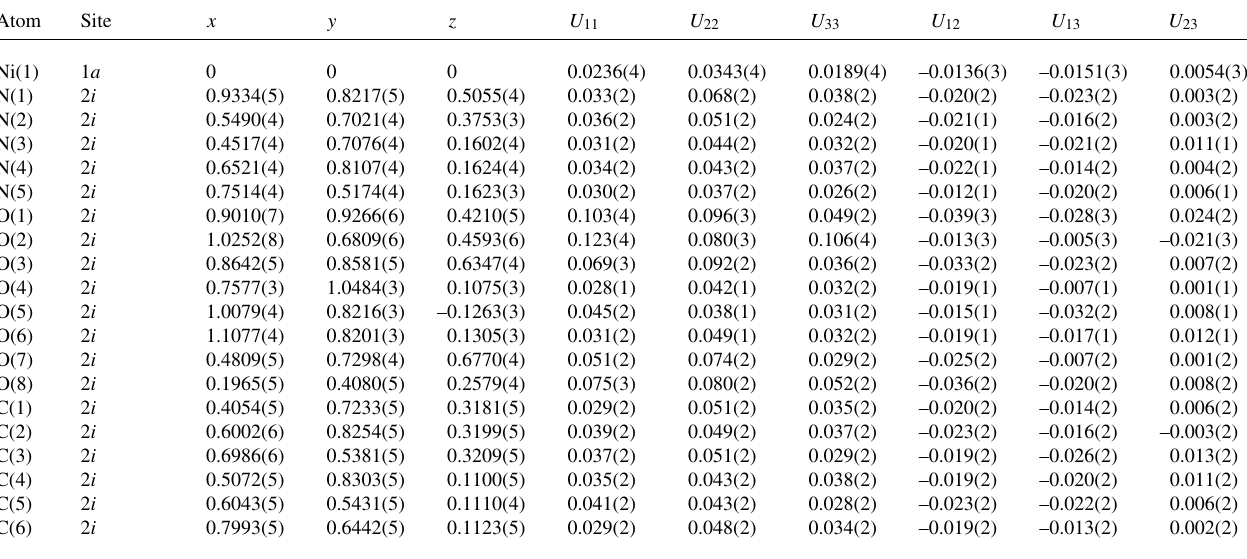
Table 3. Atomic coordinates and displacement parameters (in Å 2 ) .